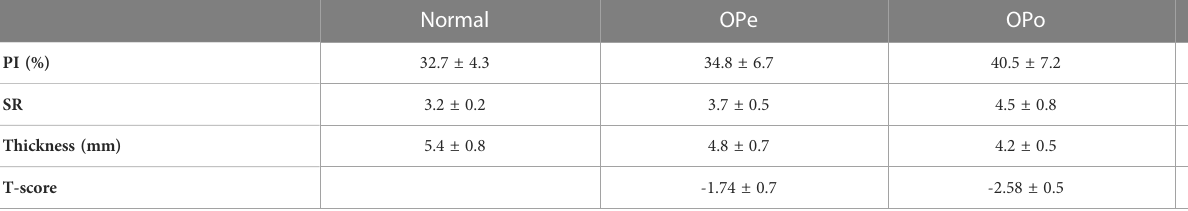
TABLE 1 Average PI, SR, bone thickness, and T-score values for different